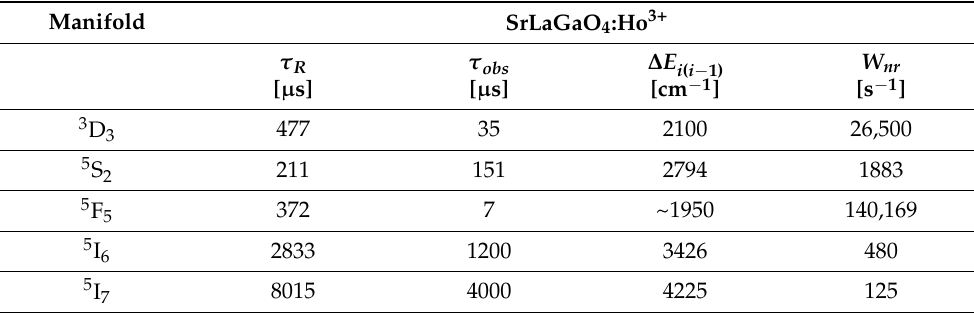
Dependence of the multiphonon transition probability W nr on the energy gap to the next lower level ∆ E can be described as an exponential function [30]: